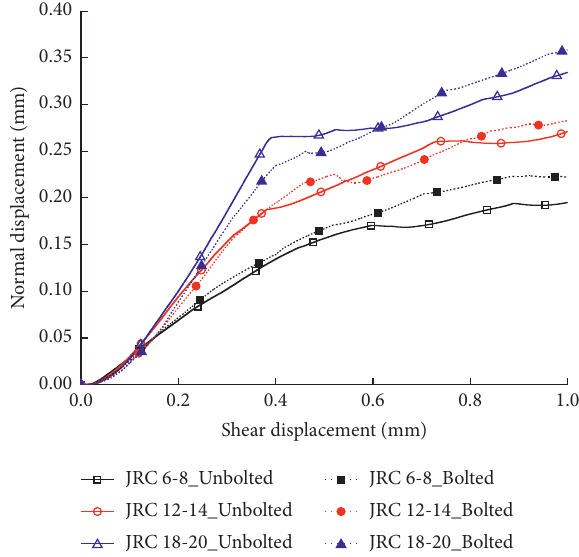
Figure 9: Relationship between normal displacement and shear displacement under different joint